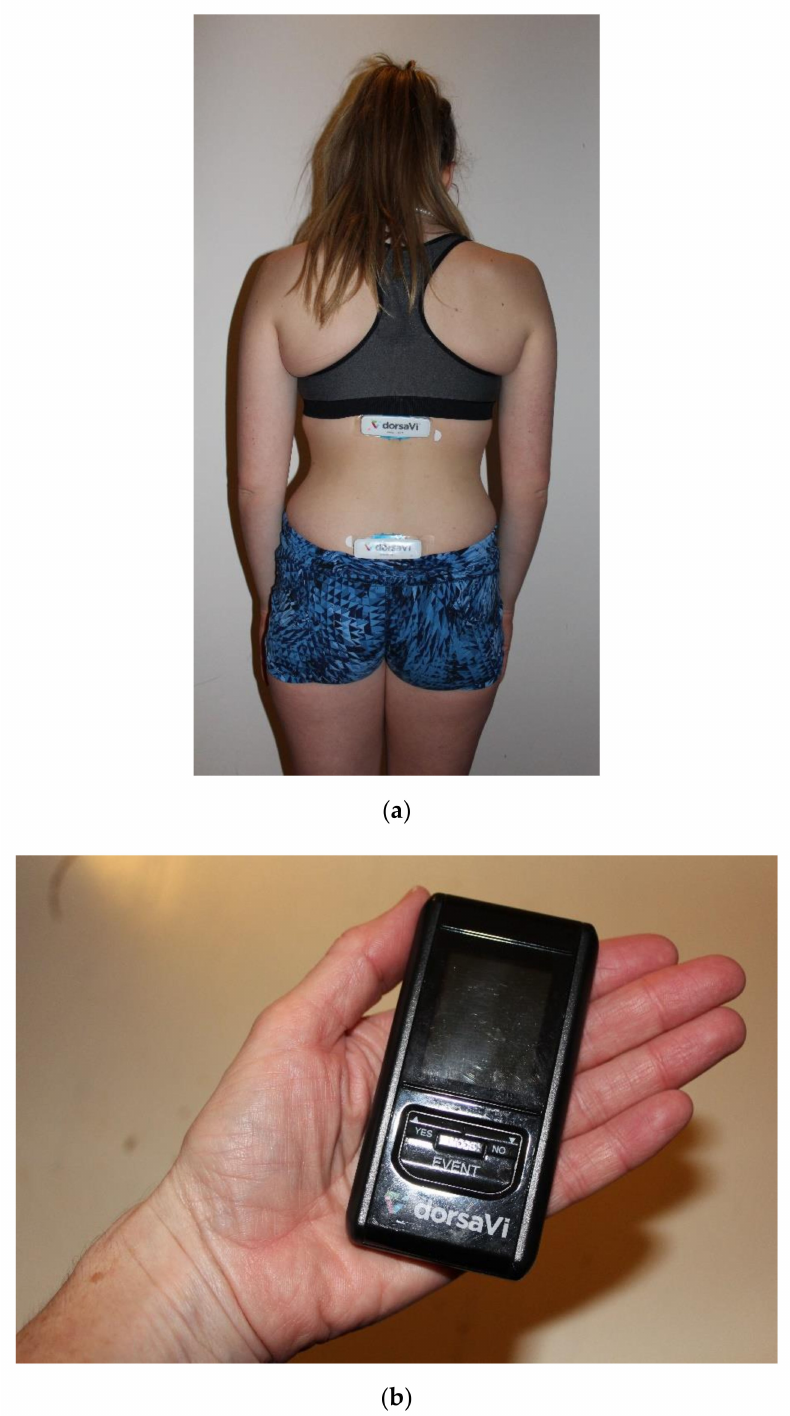
Figure 1. ( a ) ViMove TM sensor location; ( b ) Pocket recording device used by